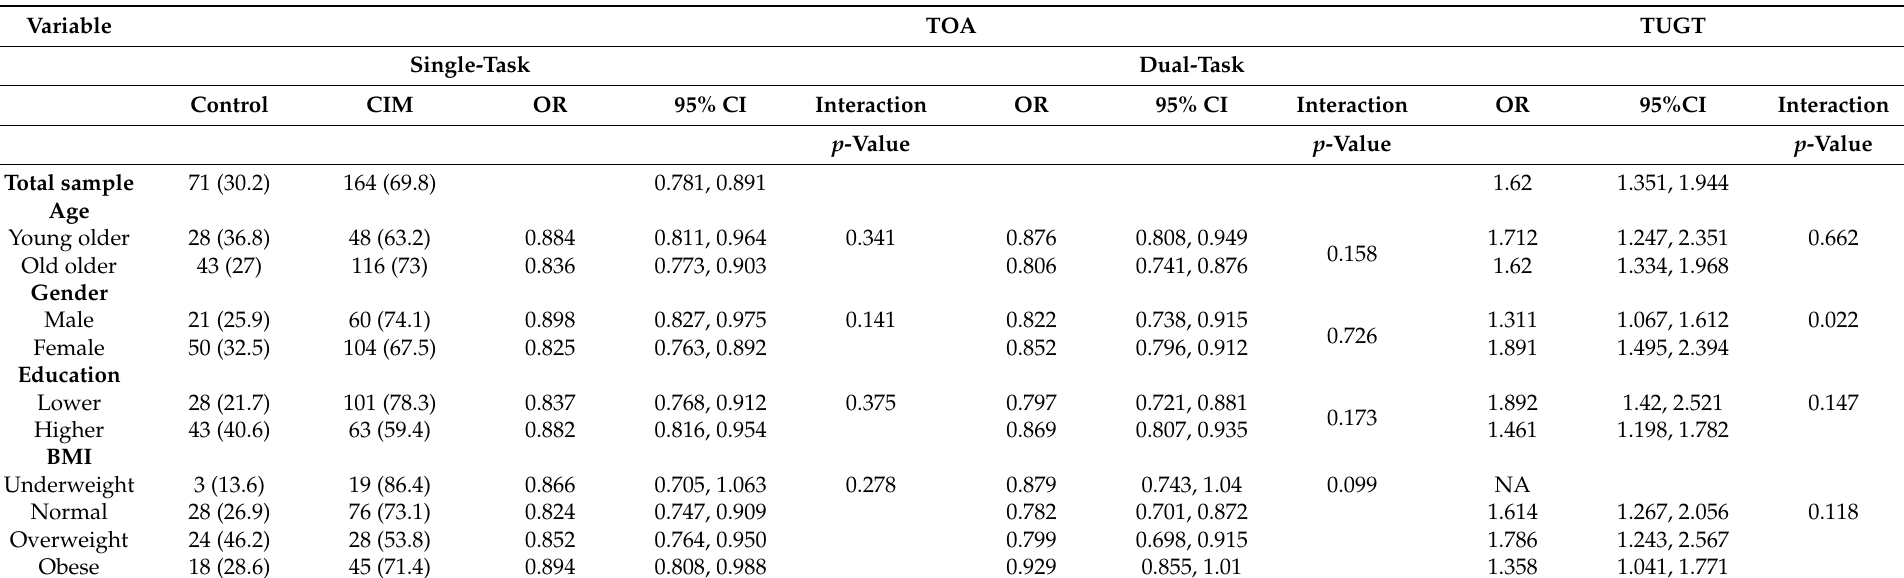
Table 5. Stratified analysis and interaction between TOA, TUGT and risk of cognitive